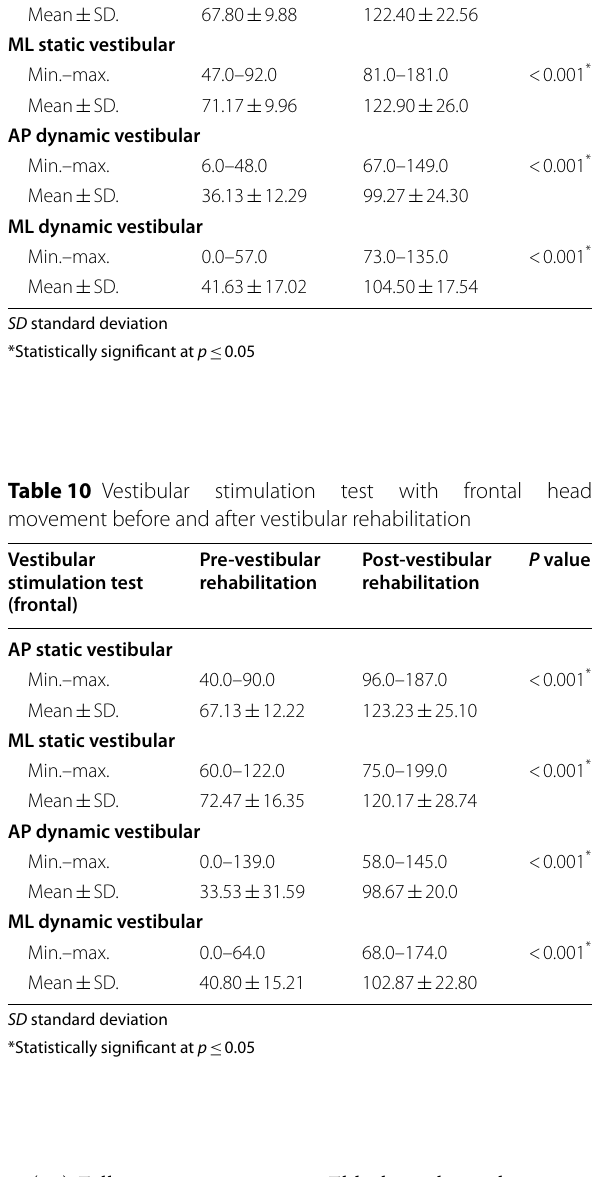
Table 7 Comparison of RQ before and after vestibular rehabilitation